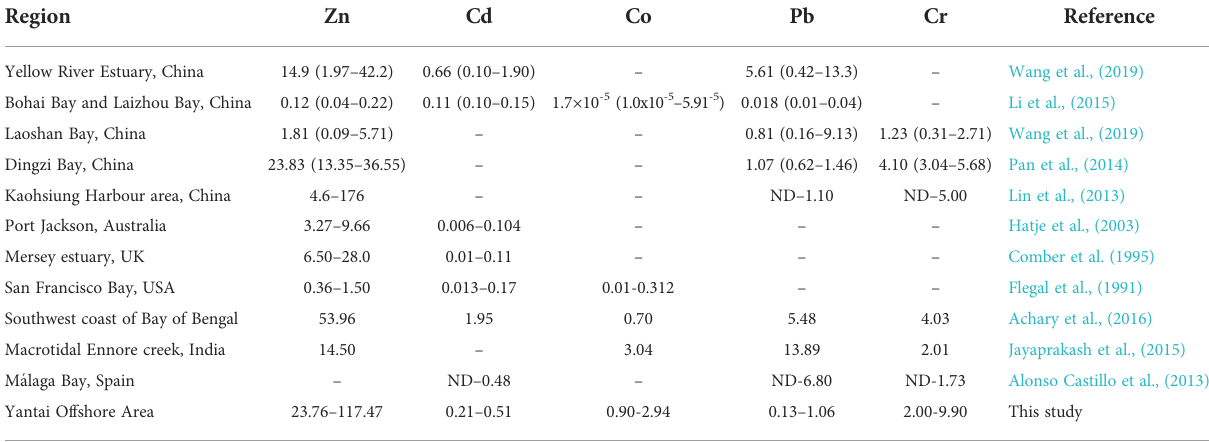
TABLE 1 Dissolved trace metal concentrations in seawater compared to other regions in the world (ug/L). Region